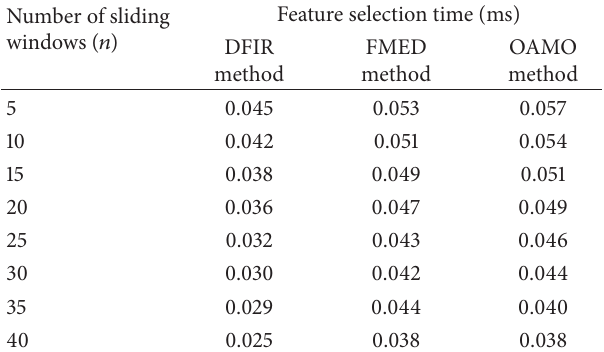
Figure 7: Measure of feature selection time. Table 4: Tabulation for feature selection